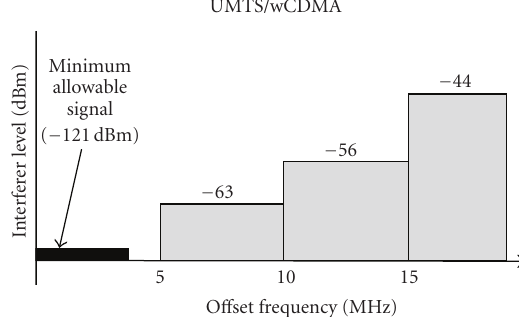
Figure 5: MARS platform